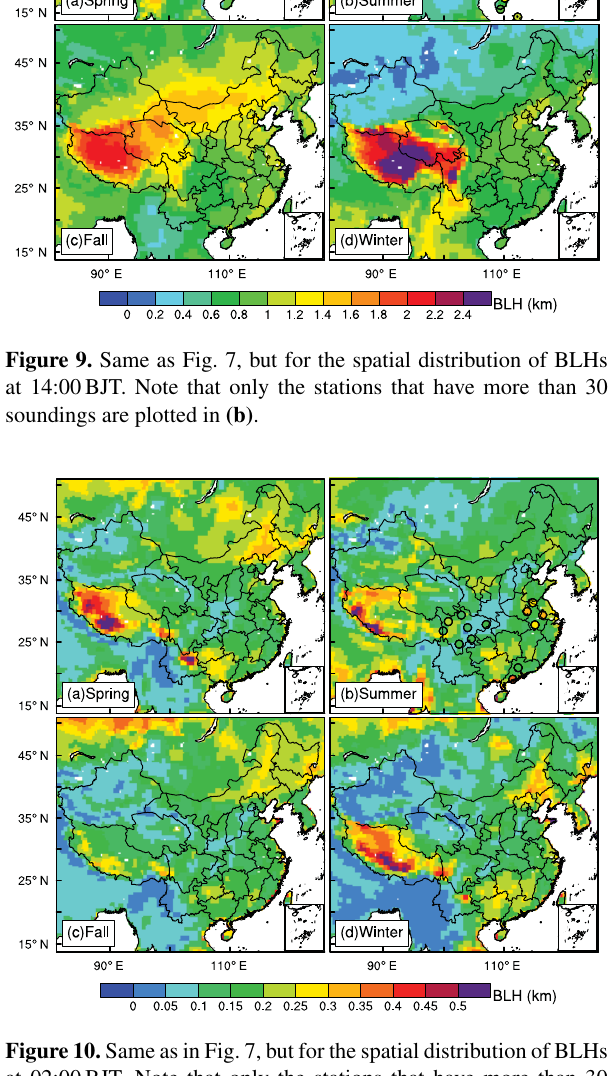
Figure 8. Same as in Fig. 7, but for the spatial distribution of BLHs at 20:00BJT.